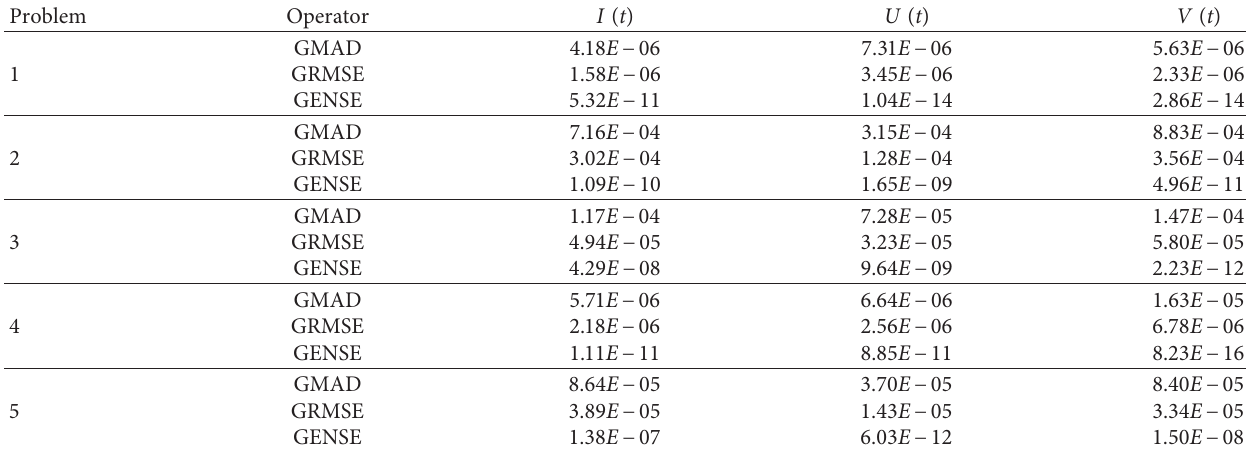
Figure 9: Graphs of performance operators. (a) MAD of problem 4, (b) RMSE of problem 4, (c) ENSE of problem 4, (d) MAD of problem 5, (e) RMSE of problem 5, and (f) ENSE of problem 5. Table 7: Values of global performance